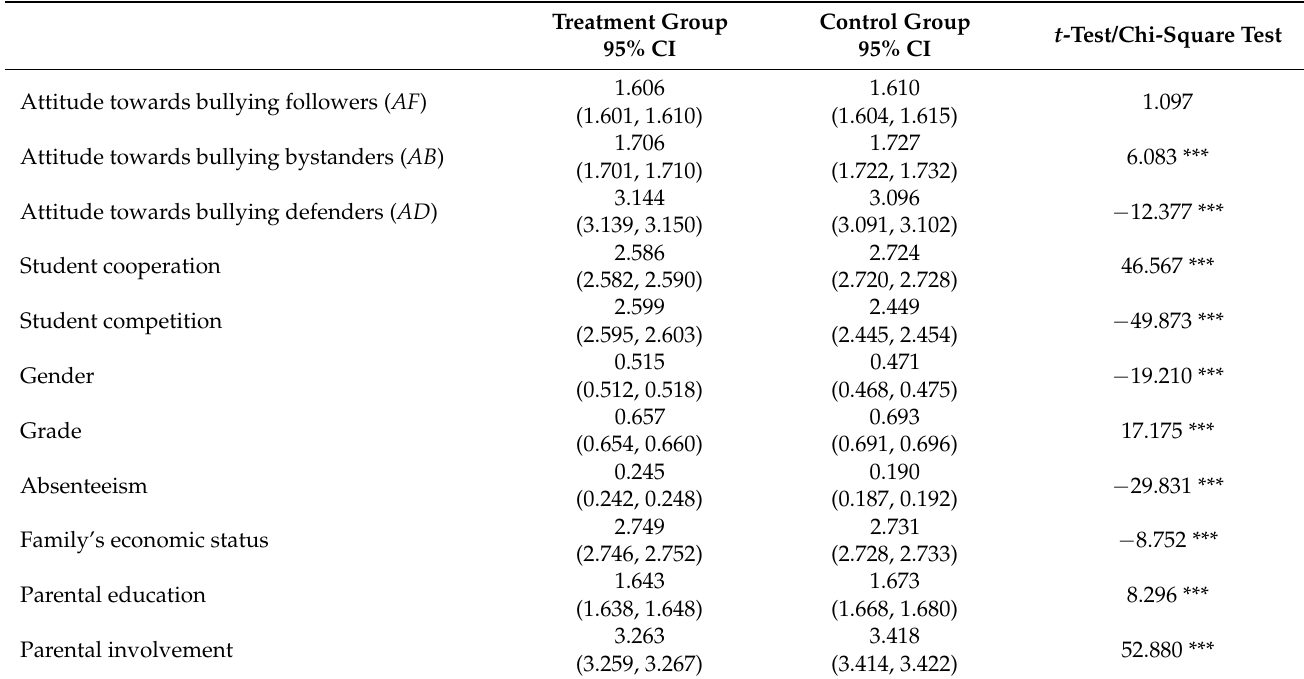
Table 2. Basic characteristics of bullied and non-bullied groups after matching. Treatment Group